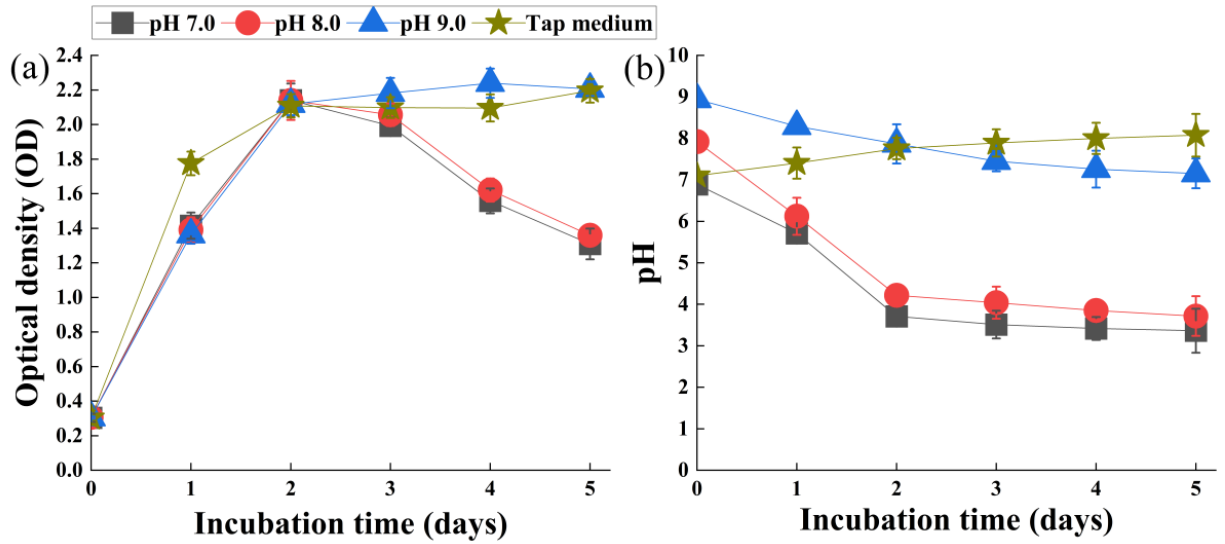
Figure 7. Growth curves of NCU-39 ( a ) and pHs ( b ) at different initial pHs in 5-fold diluted anaer- obic digestion piggery effluents (ADPEs) pretreated by 3-day fungal decolorization. Tap medium was used as a control. Error bars represent standard deviations ( n = 3).